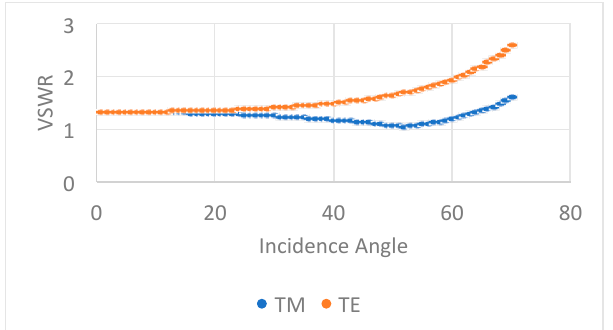
Figure 4. VSWR for TE and TM polarizations in the UV region at the keratin–melanin interface; VSWR is higher than one for all incidence angles. From our simulation results, VSWR values go from one to five. At resonance, the VSWR is close to one, corresponding to Brewster’s angle condition or equivalently zero reflectivity for TM polarization.